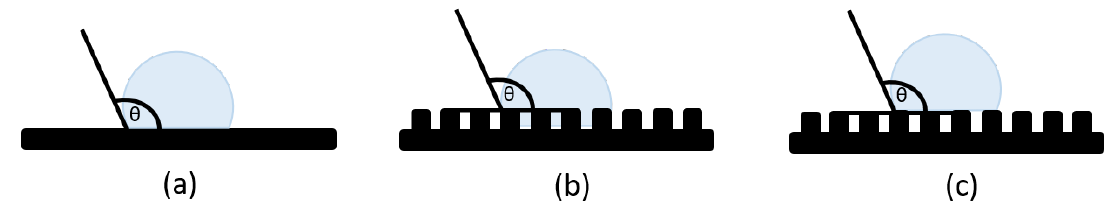
Figure 4. Scheme representing the three contact angles, ( a ) Young regime, ( b ) Wenzel regime, ( c ) Cassie–Baxter regime.